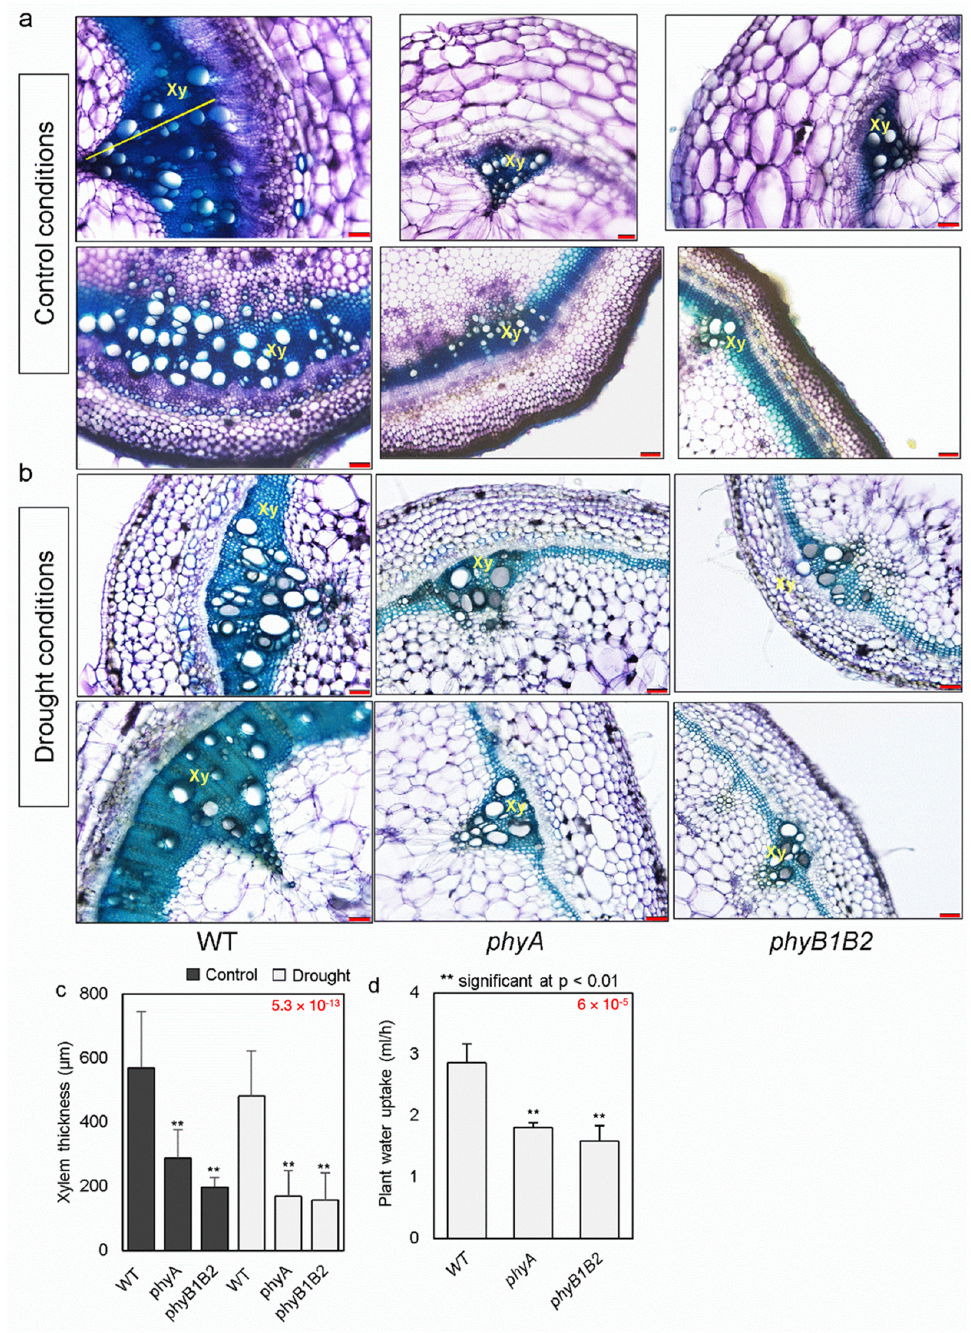
Figure 4. The xylem and water uptake in WT, phyA, and phyB1B2 plants. The xylem structure of a month-old plants after 8 days (d) under non-stress (control) ( a ) and drought conditions ( b ). Xy refers to the xylem area. The yellow line represents the xylem area thickness. Scale bars (red lines) represent 100 µ m. ( c ) Xylem area thickness of one-month-old plants after 8 d water withholding compared to control conditions. ( d ) The level of water uptake by one-month-old plants under control conditions. Data represent the average ( n ≥ 4) ± SD (standard deviation) from a representative of three biological individualistic experiments. Double asterisks represent statistically significant differences at p < 0.01. Comparisons were conducted under control and drought conditions separately for plant xylem area thickness, whereas under control conditions for water uptake level following a post hoc Tukey HSD test with ANOVA. The ANOVA p-values are shown in red. Additionally, the p -values of the post hoc test are presented in Supplementary Materials (Table S2).